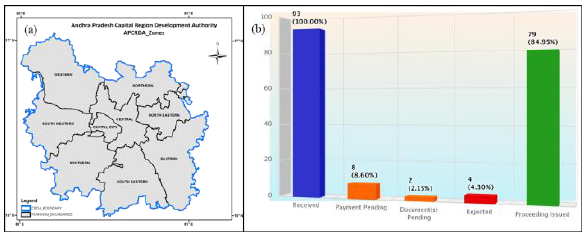
Figure 1: (a) Andhra Pradesh Capital Region Development Authority (APCRDA) jurisdiction (b) Statistics of Occupancy Building permissions through APDPMS